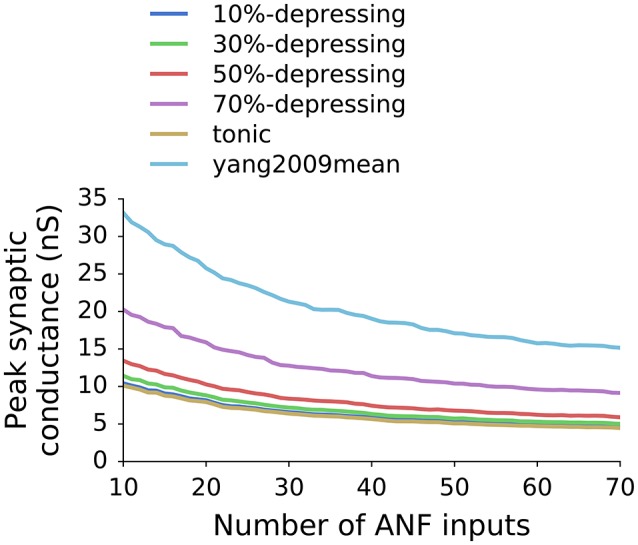
Optimal peak synaptic conductance as a function of the number of ANF inputs to a GBC and the synapse type (depression level).